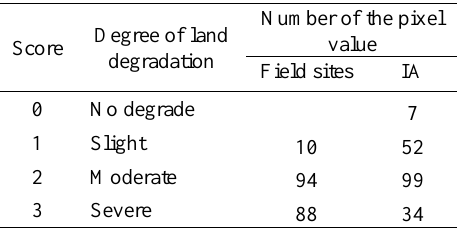
Table 3. Comparison between field measurement of vegetation and estimated integrated